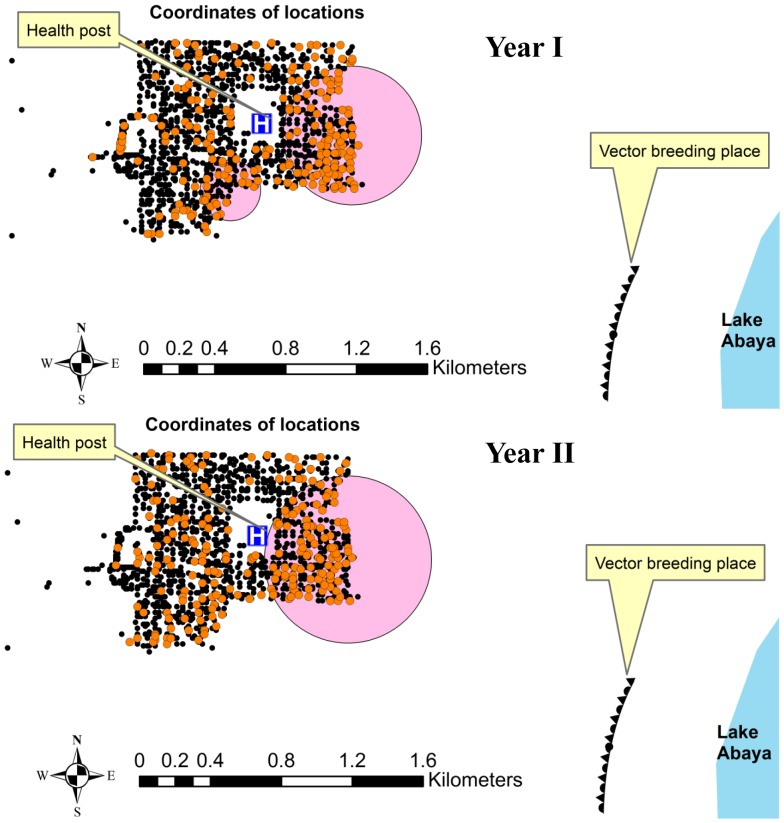
Most likely (big) and secondary (small) clusters (shaded circles) of malaria episodes (both types) according to study year- orange dots refer to all malaria episodes of the corresponding year.